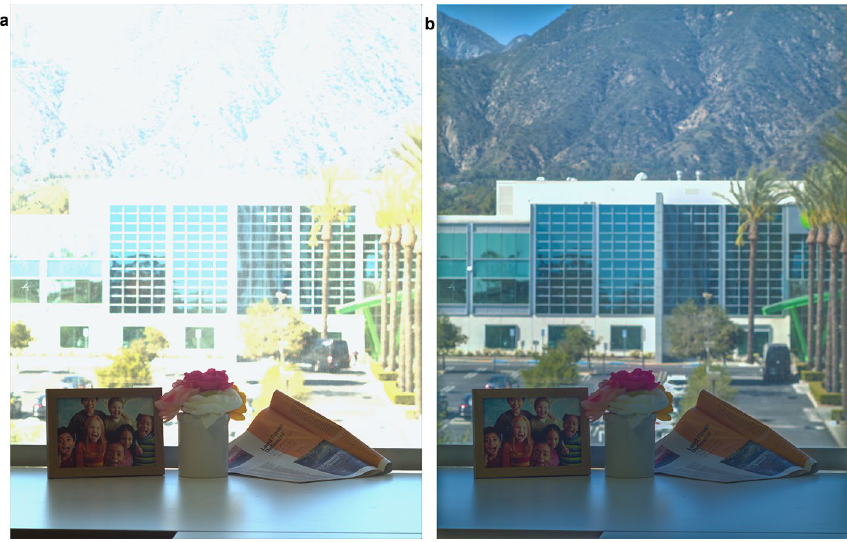
Figure 6. Sample images under HDR condition with and without DPG operation. The sample images were taken 2 × 2 binning with a F/8.0 lens and 100 ms exposure time. ( a ) HCG only. ( b ) DPG